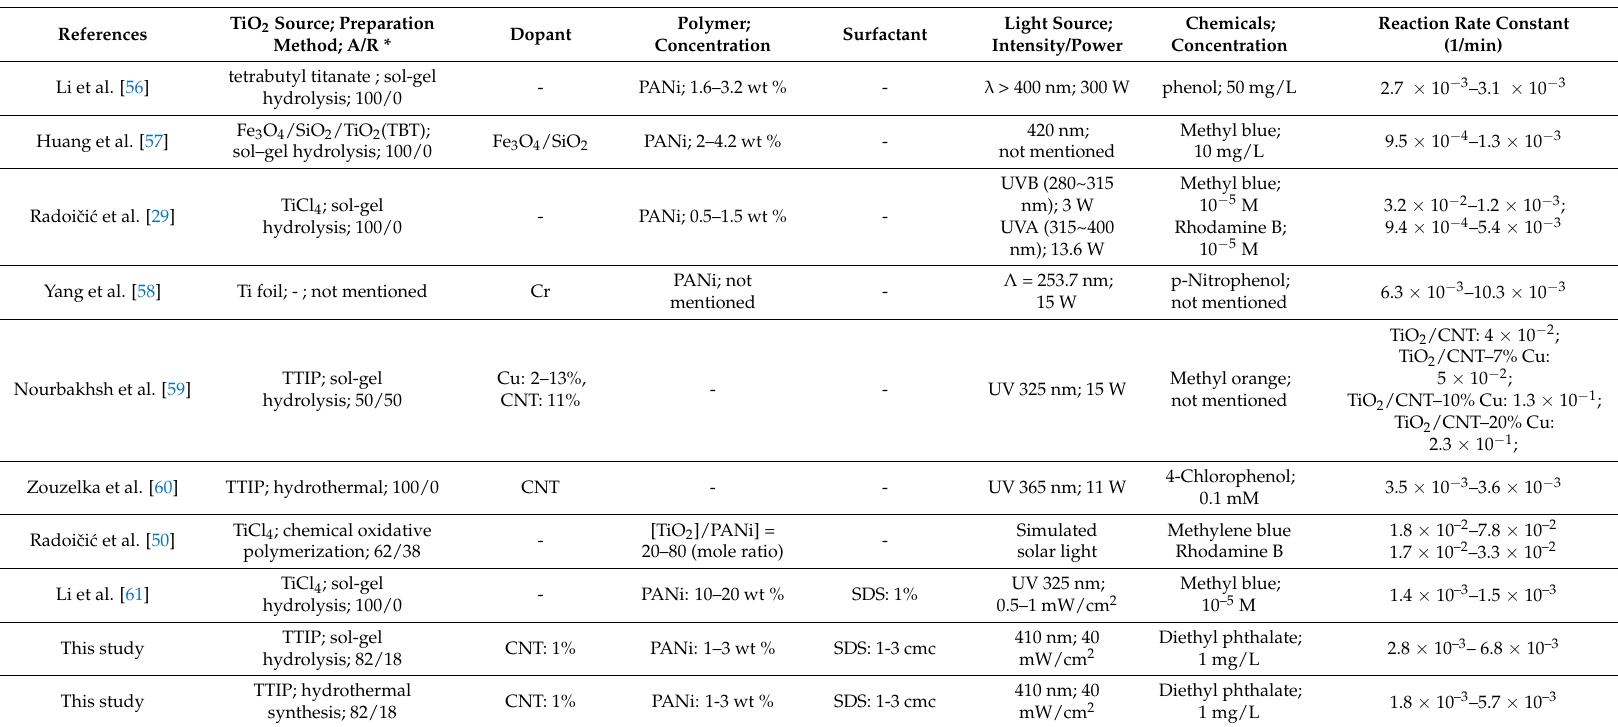
Table 1. Comparative photocatalytic performance of TiO 2 -based